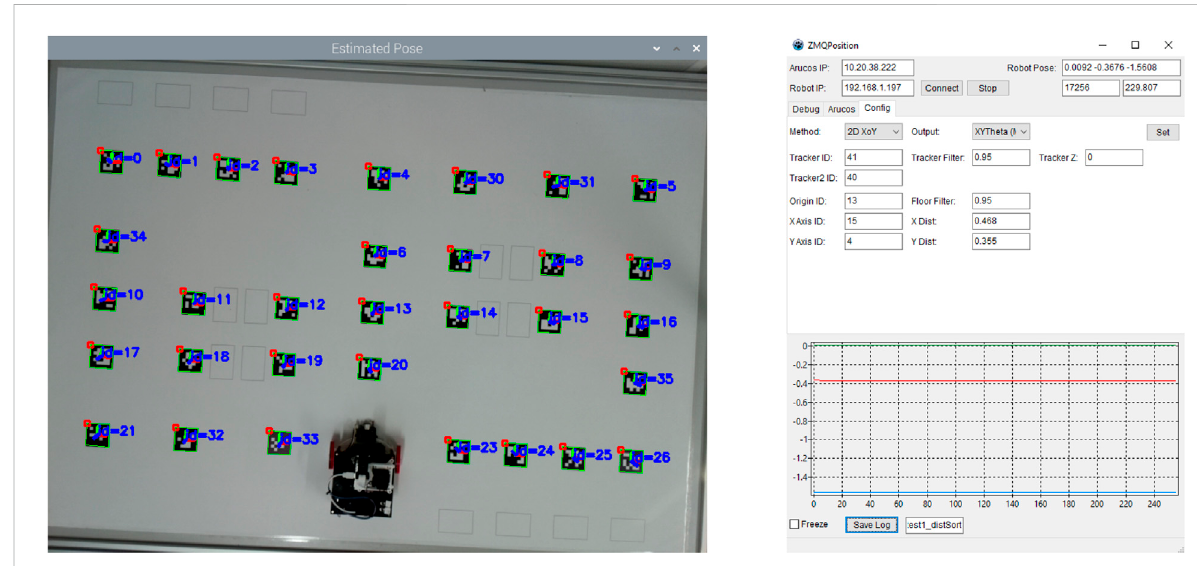
FIGURE 13 Ground truth system ’ s perspective (left). Ground truth graphical application (right).